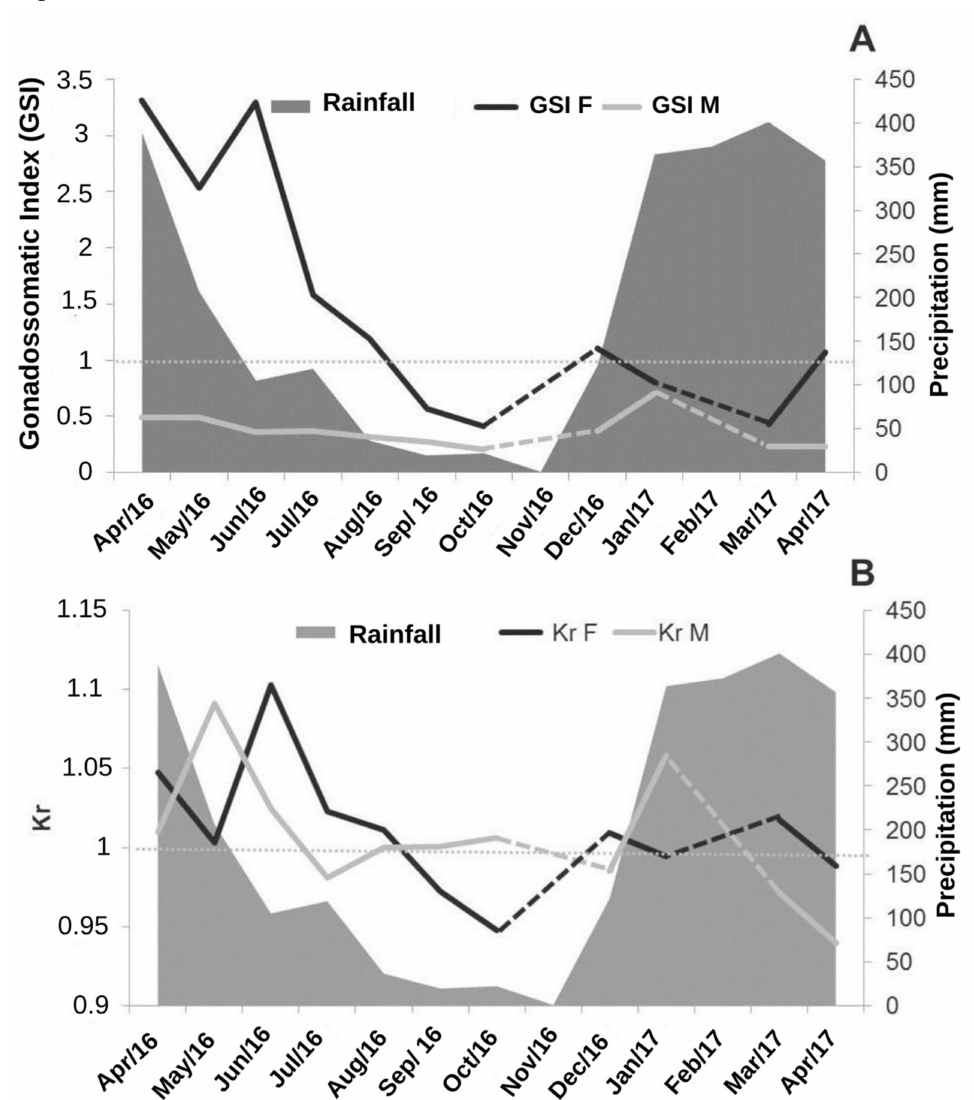
Figure 5. Average of gonadosomatic index by month (GSI- A ) and relative factor condition (Kr- B ) of Genyatremus luteus females and males in an Amazon estuary, Brazil, considering the precipitation level. GSI F: females’ gonadosomatic index; GSI M: males’ gonadosomatic index; Kr F: females’ factor condition; Kr M: males’ factor condition. Dashed lines gray and black indicate no specimens collected, even with the same sample effort. Dashed point line represents Kr = 1. Estimated L 50 values were 15.13 cm for females, 14.29 cm for males, and 14.78 cm for sex combined (Figure